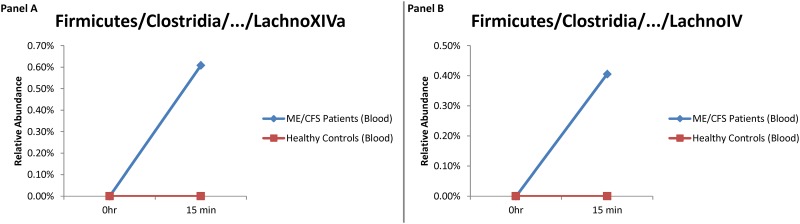
Relative abundance of (A) Firmicutes/Clostridia/…/LachnoXIVa and (B) Firmicutes/Clostridia/…/LachnoIV in blood samples collected at baseline and 15 minutes after exercise challenge in ME/CFS patients and healthy controls.